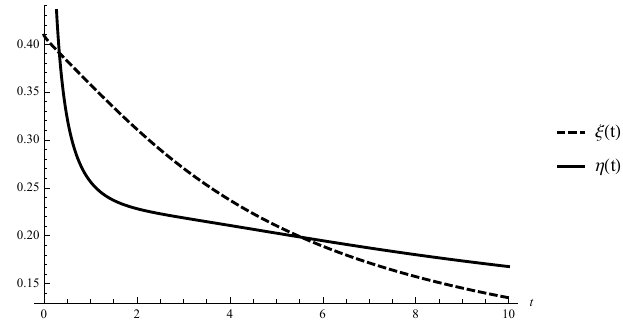
Figure 4. Example 9. Graph of the functions ξ ( t ) and η ( t ) for q =